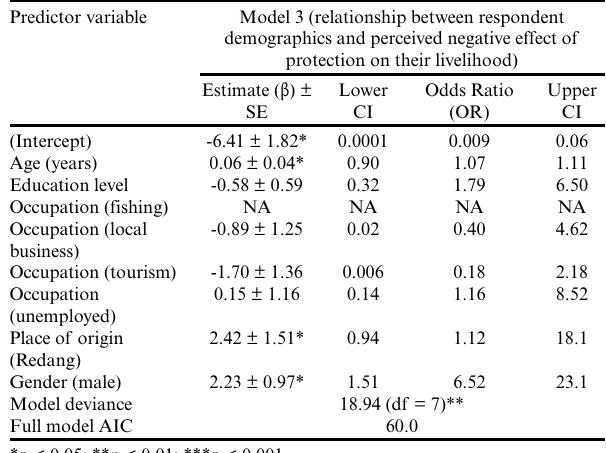
medicinal beliefs in turtle eggs and the threat status of turtles (Table 7). Those who believed in the medicinal properties of eggs were more likely to consume turtle eggs ( β = 2.44, SE = 0.90, p < 0.01). Respondents who perceived that turtles were threatened were less likely to consume turtle eggs ( β = -2.26, SE = 1.06, p <